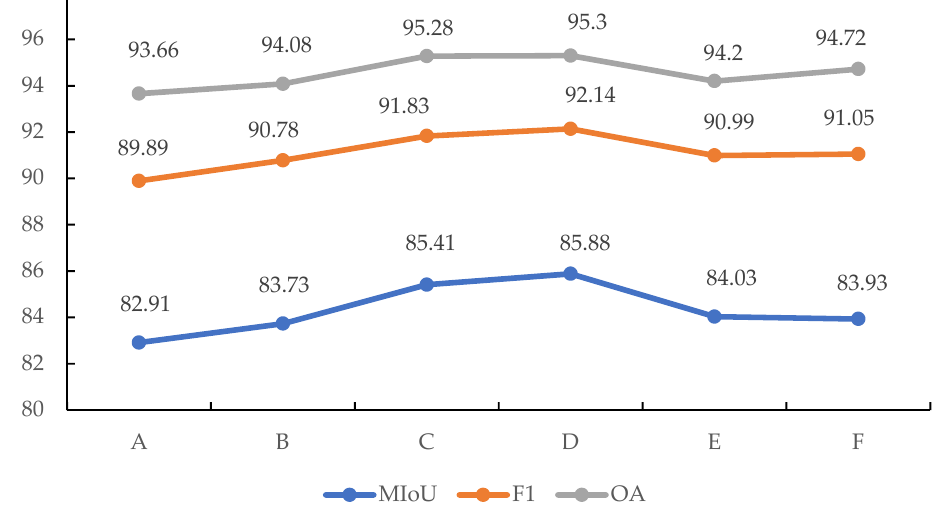
Figure 13. Line charts of three different precision evaluations for different dilation rate combinations, where ( A ) refers to experiment without dilated convolution, ( B ) refers to the combination of dilation rate (1, 2, 4, 8), ( C ) refers to the combination of dilation rate (1, 2, 4, 8, 16), ( D ) refers to the combination of dilation rate (1, 2, 4, 8, 16, 32), ( E ) refers to the combination of dilation rate (1, 2, 4, 8, 16, 32, 48), and ( F ) refers to the dilation rate combination of (1, 2, 4, 8, 16, 32, 48, 64).